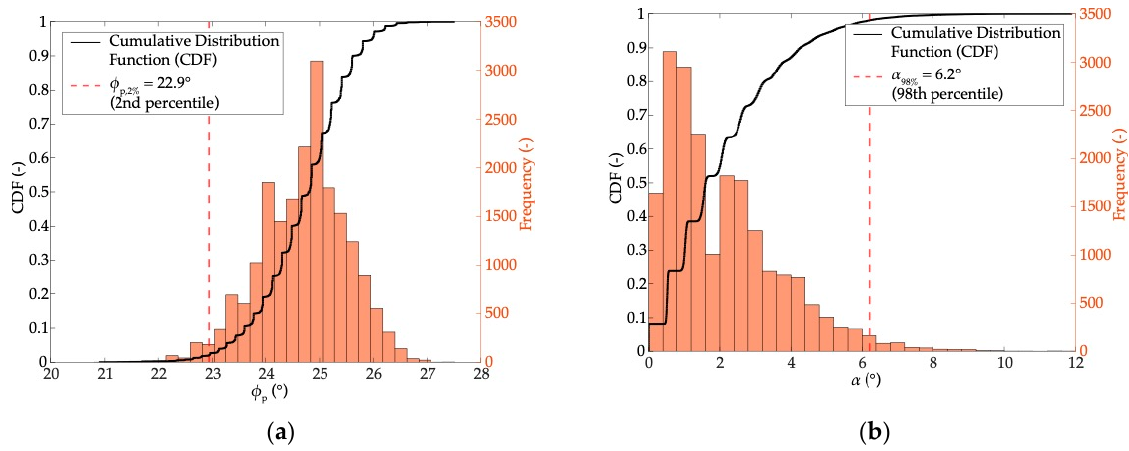
Figure 4. Examples of the typical histograms and cumulative distribution functions (CDFs) of ( a ) the energy angle φ p and ( b ) the lateral angle α obtained in the case of 5 m 3 spherical block, 0 trees/ha, and ω 2 = 30 ◦ .